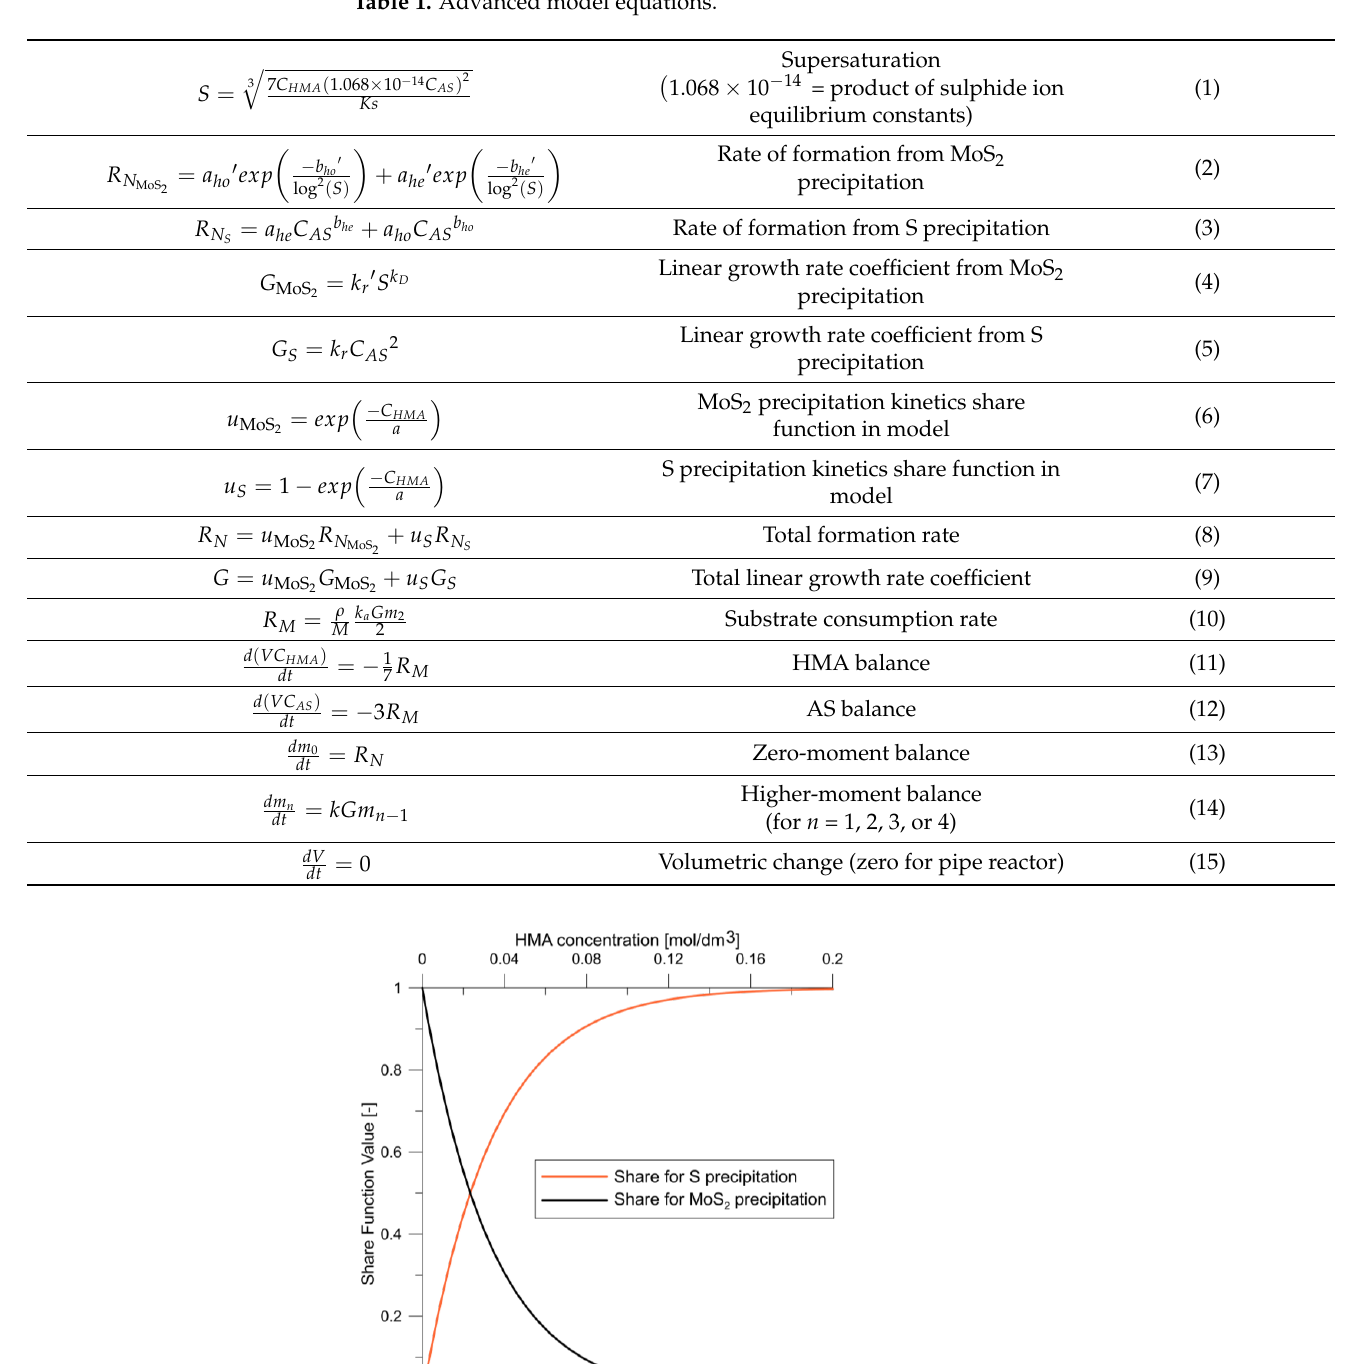
Table 1. Advanced model equations.